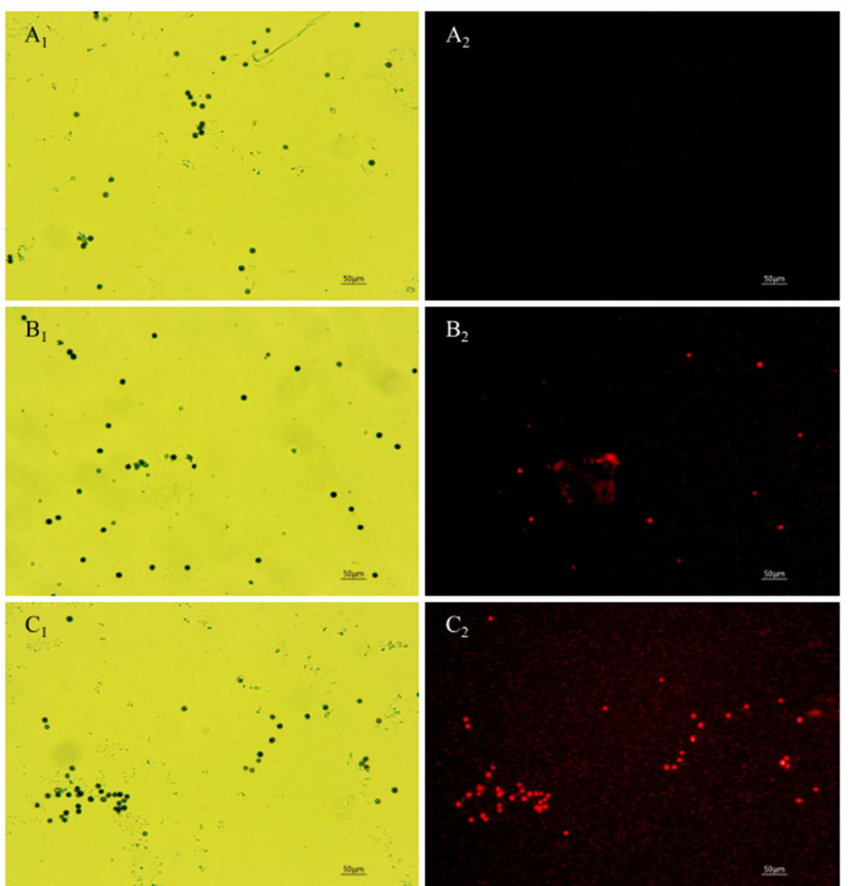
Figure 6. Effect of anti-fungal peptides treatment on membrane permeability of A. carbonarius H9 spores. ( A 1 , A 2 ) control group under bright field and fluorescent field; ( B 1 , C 1 ) spore membrane treated by 1.6 and 6.4 mg/L polypeptides under bright fields; ( B 2 , C 2 ) spore membrane treated by 1.6 and 6.4 mg/L polypeptides under fluorescent fields.